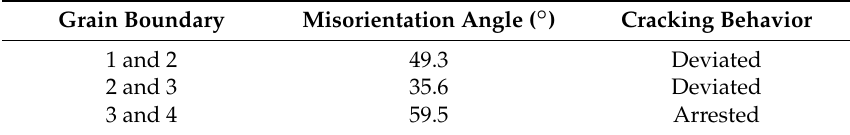
Figure 14. Typical inverse pole figure map displaying grain boundaries with different crystal orientations in a Q&T–treated sample at T t = 700 ◦ C. Dotted arrow line stands for the crack propagation direction; black solid arrow line denotes high-angle grain boundaries (HAGBs) and red solid arrow lines indicate low-angle grain boundaries (LAGBs). Table 5. Effects of HAGBs on SSC propagation behavior shown in Figure 14.